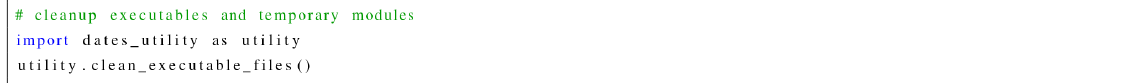
Figure 12. Cleanup of DATeS executable files.